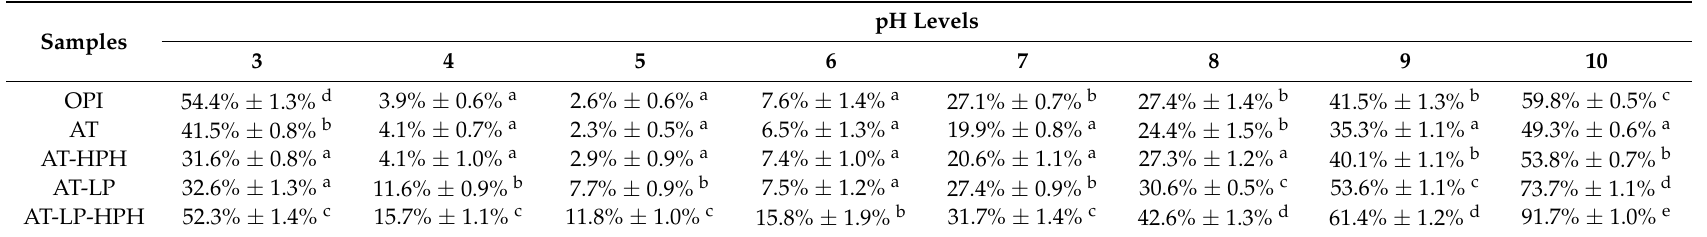
Table 1. Protein solubility of OPI and the modified samples at different pH